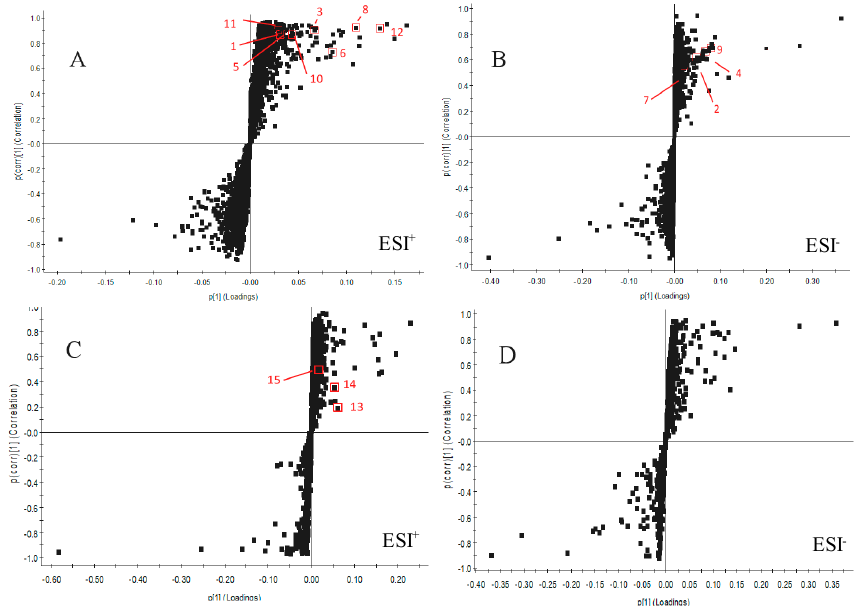
Figure 6. OPLS-DA S -plots of urine metabolic profilings ( A , B ) and blood metabolic profiles ( C , D ) of the XT group and BM group in ESI + and ESI − . (the numbers of potential biomarkers correspond to the list in Table 3).